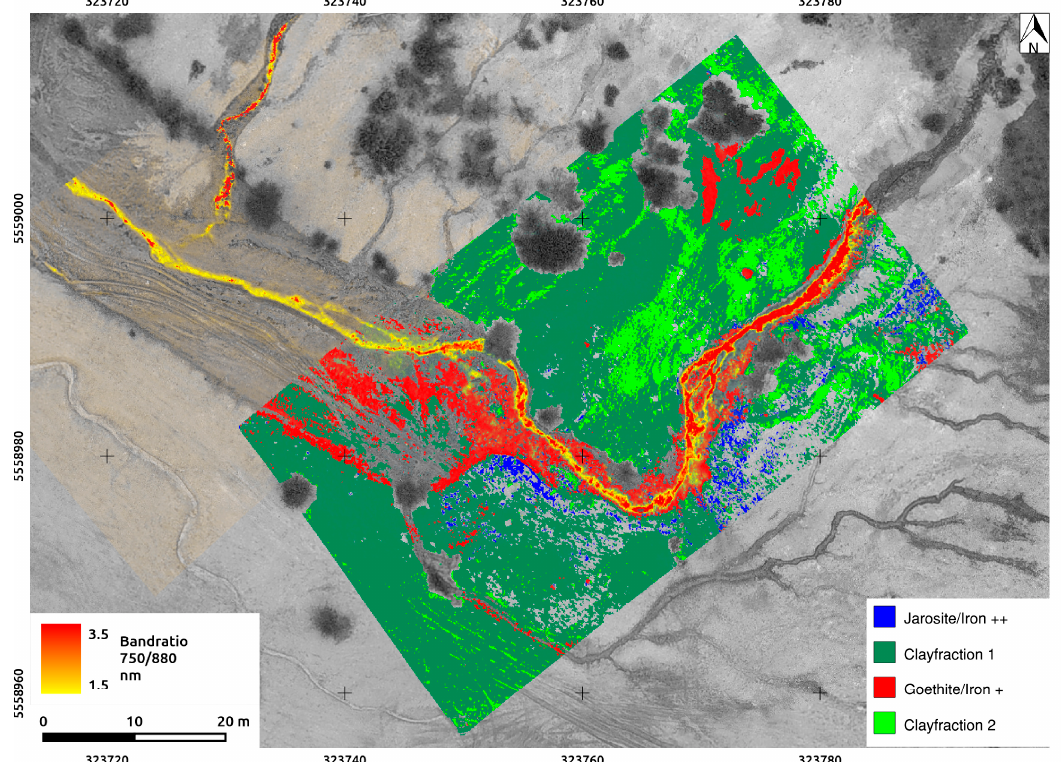
Figure 11. The combined result of three HSIs combined. The overlaid image is of a Rikola band-ratio (May) of 750/880 nm, highlighting only the stream. The second applied method is the SAM classification (May) with the endmember library as the target spectra. The high HSI resolution (5 cm) enables detailed mapping, thus accentuating the iron crusts bordering the stream. The combination of the two methods reveals a conclusive picture of the mapping capability of Rikola HSIs.